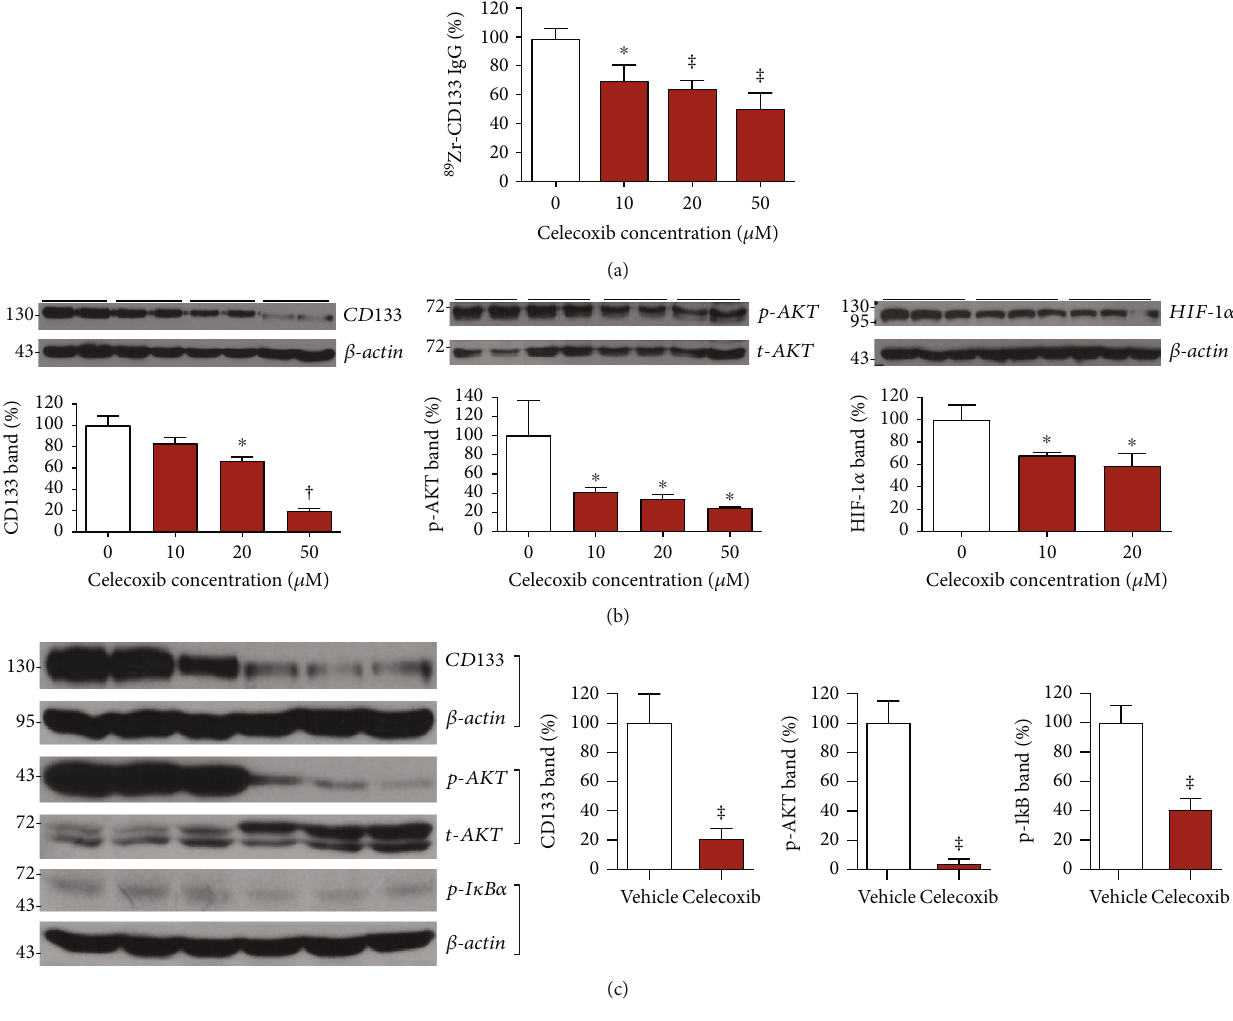
Figure 4: E ff ects of celecoxib on HT29 cell signaling pathways. (a) 89 Zr-CD133 IgG binding. (b) Immunoblots and quanti fi ed band intensities of CD133 (left), HIF-1 α (middle), and p-AKT (right) after 24 hours of treatment with graded doses of celecoxib. (c) Immunoblots and quanti fi ed band intensities of total cellular CD133 and p-AKT and cytosolic p-I κ B α . Bars are means ± SD of % controls obtained from triplicate (A binding and C) or duplicate samples per group (A immunoblots and B). Band intensities are corrected by β -actin (CD133 and p-I κ B α ) or t-AKT (p-AKT). ∗ P < 0 : 05 , † P < 0 : 005 , and ‡ P < 0 : 001 , compared to